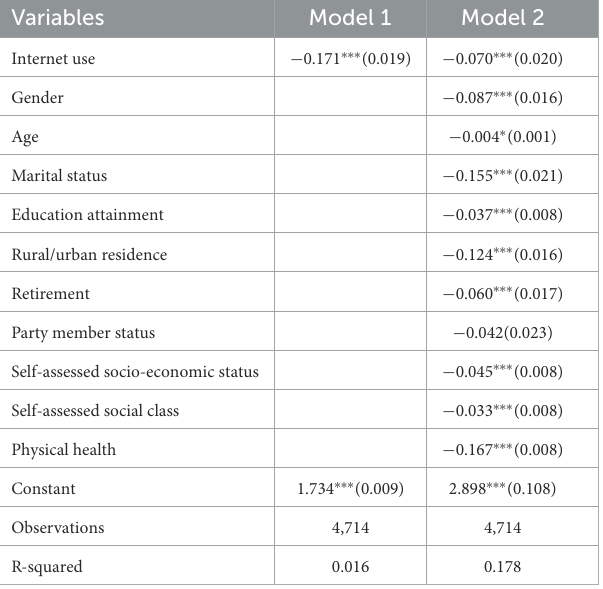
TABLE 2 The benchmark regression results on internet use and